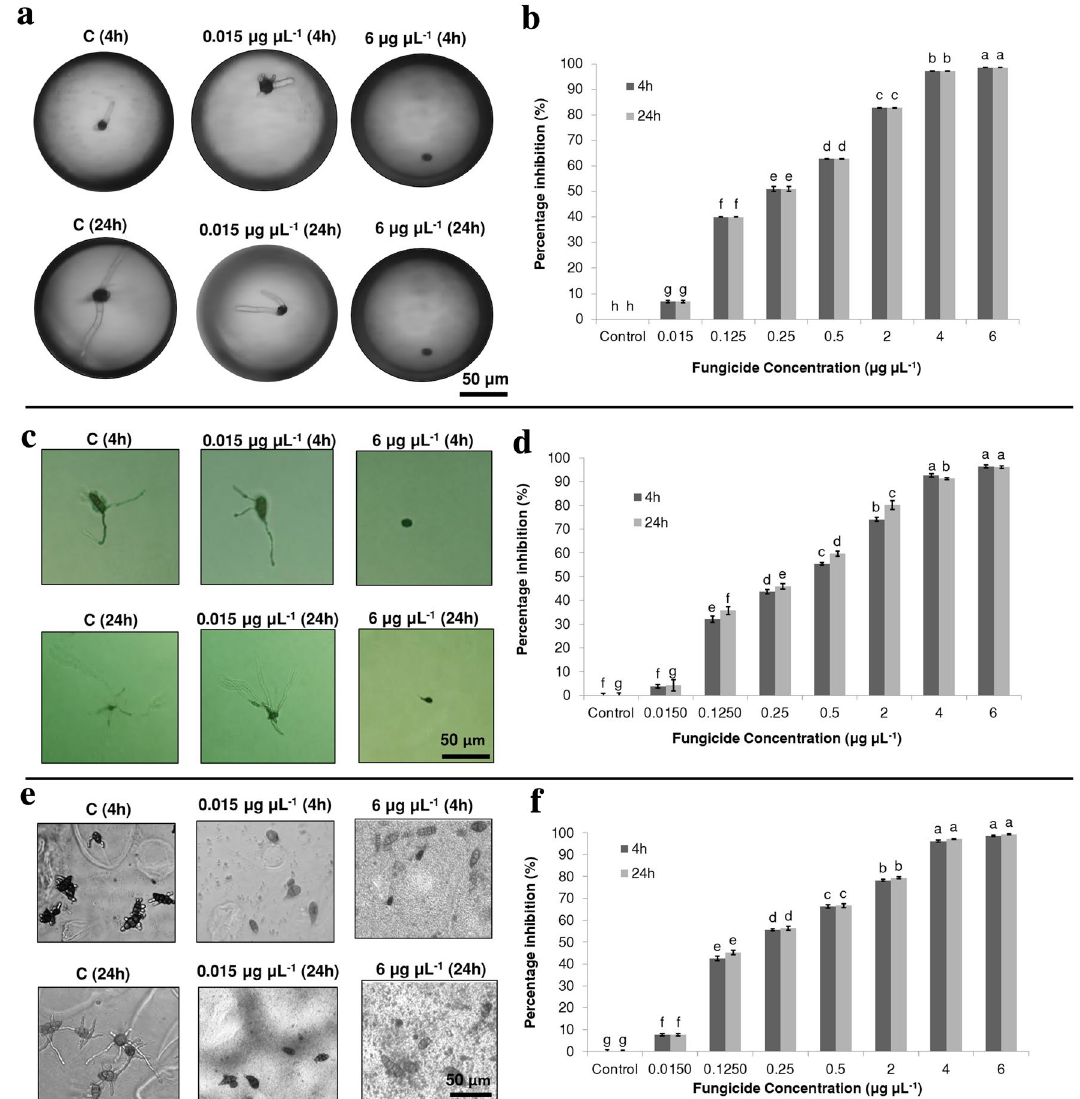
Figure 4. In vitro antifungal efficacy of kunshi against spore germination of Alternaria alternata assessed by droplet-, WA, and 96-well plate assays. ( a ) spores of A. alternata after treatment with fungicide at 4 h and 24 h incubation assessed by droplet assay, scale bar 50 µm ( b ) percentage inhibition of kunshi against A. alternata in droplet assay, ( c ) spores of A. alternata after treatment with fungicide at 4 h and 24 h incubation assessed by WA assay, scale bar 50 µm, ( d ) percentage inhibition of kunshi against A. alternata in WA assay, ( e ) spores of A. alternata after treatment with fungicide at 4 h and 24 h incubation assessed by 96-well plate assay, scale bar 50 µm, ( f ) percentage inhibition of kunshi against A. alternata in 96-well plate assay. Error bars represent ± standard error of means (n = 6 in case of WA and 96-well plate, n = 140 in case of droplet assay). Each concentration with different letters is significantly different from each other ( P < 0.05; Statistix 8.1). The significance was calculated by Tukey’s HSD post-hoc test ( P =